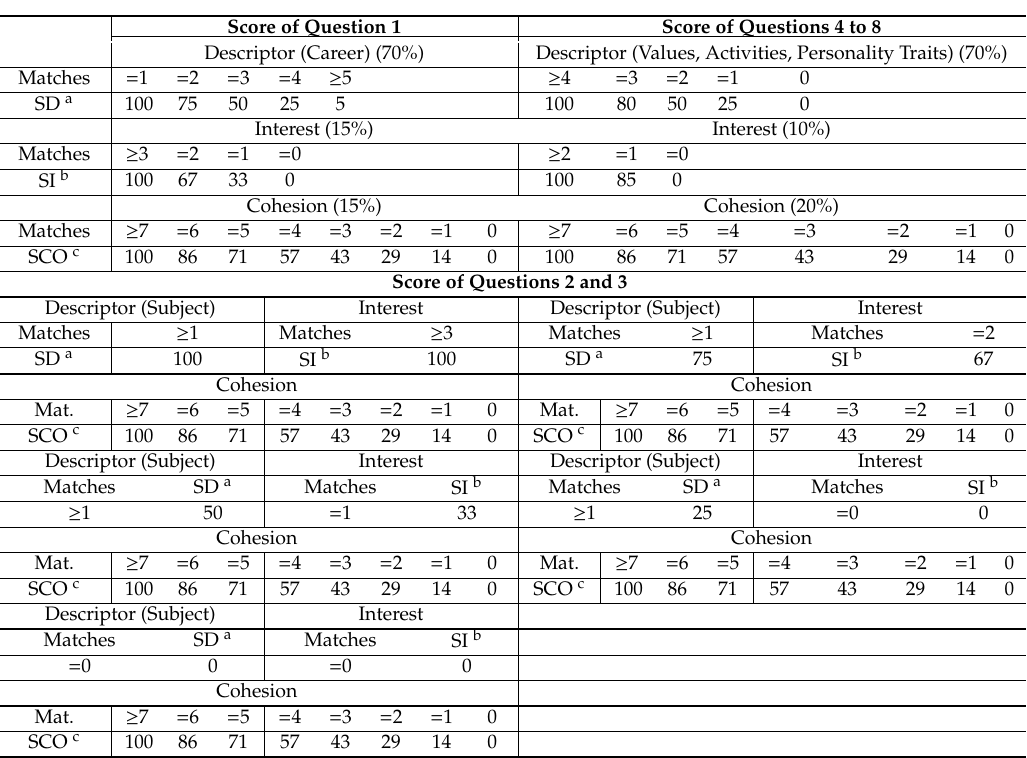
Table 3. Score of the answer.